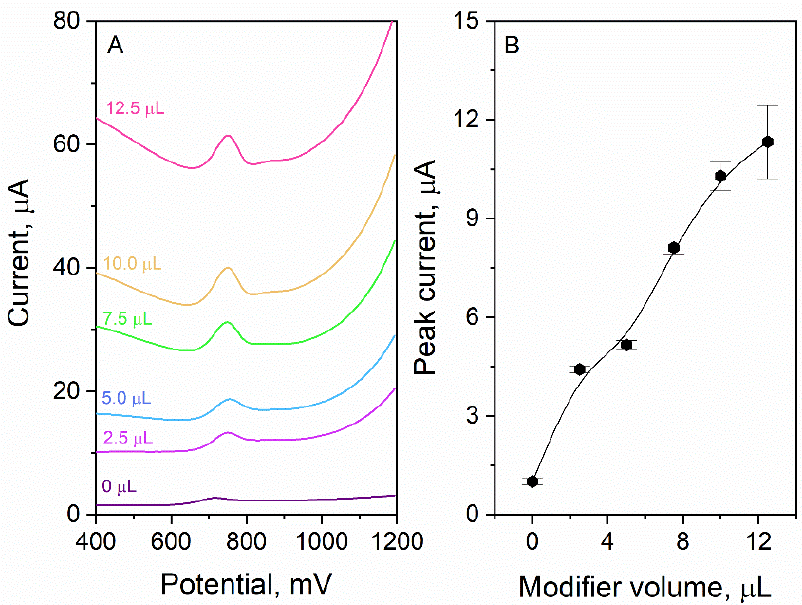
Figure 3. Dependence of the volume of applied surface modifier on the CTZ signal. Experiment conducted in 0.1 M phosphate buffer, CTZ concentration was equal to 10 µM. ( A ) DPV voltammograms, ( B ) graph.